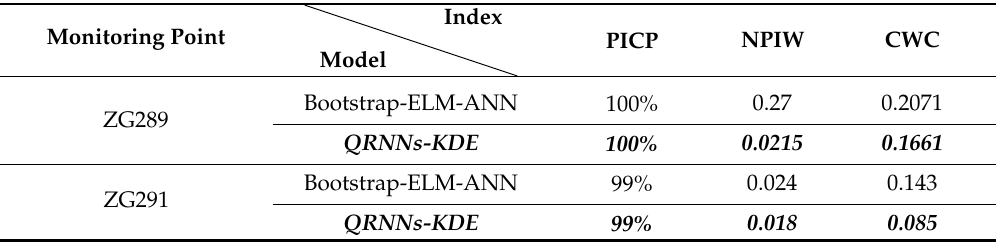
Table 3. Comparisons of 90% PIs obtained from Bootstrap-ELM-ANN and QRNNs-KDE for the Fanjiaping